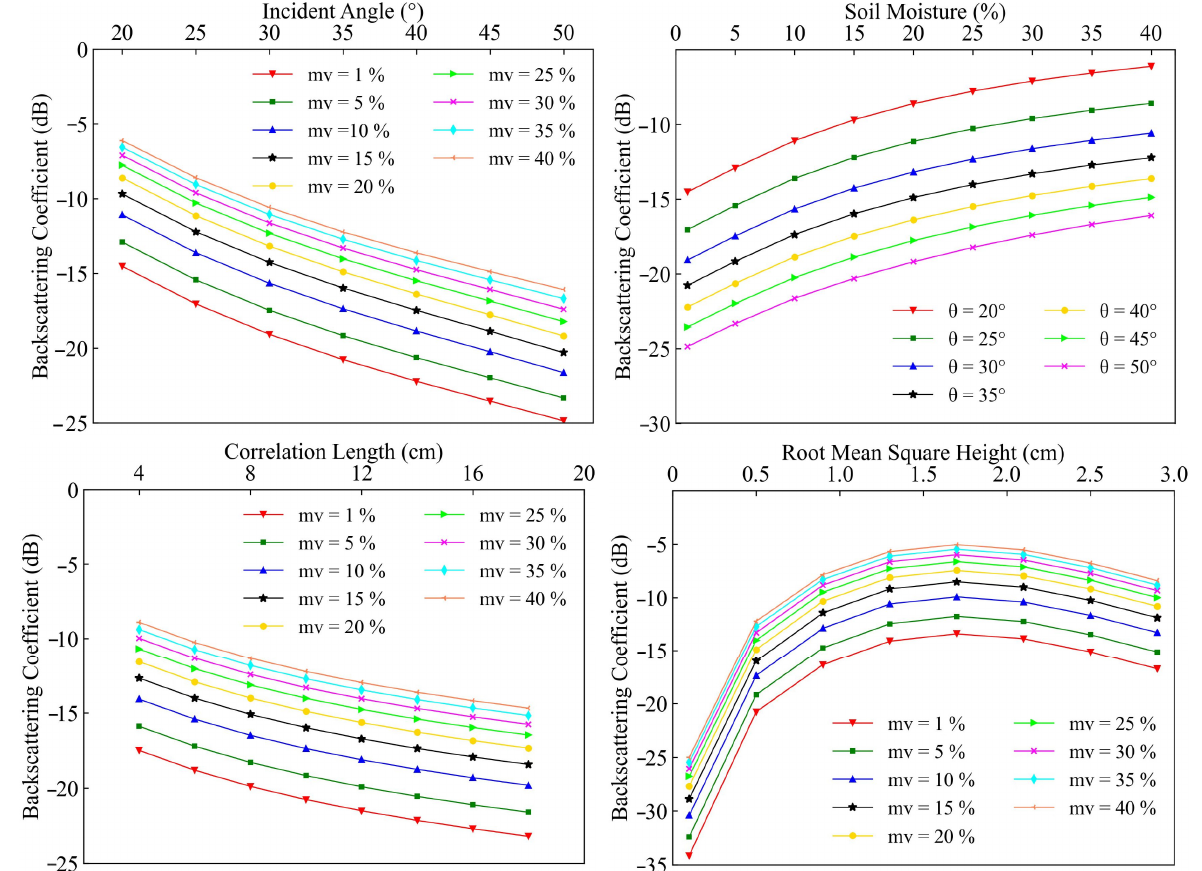
Figure 3. Response of backscattering coefficient to the surface parameters with AIEM (mv is soil moisture content).